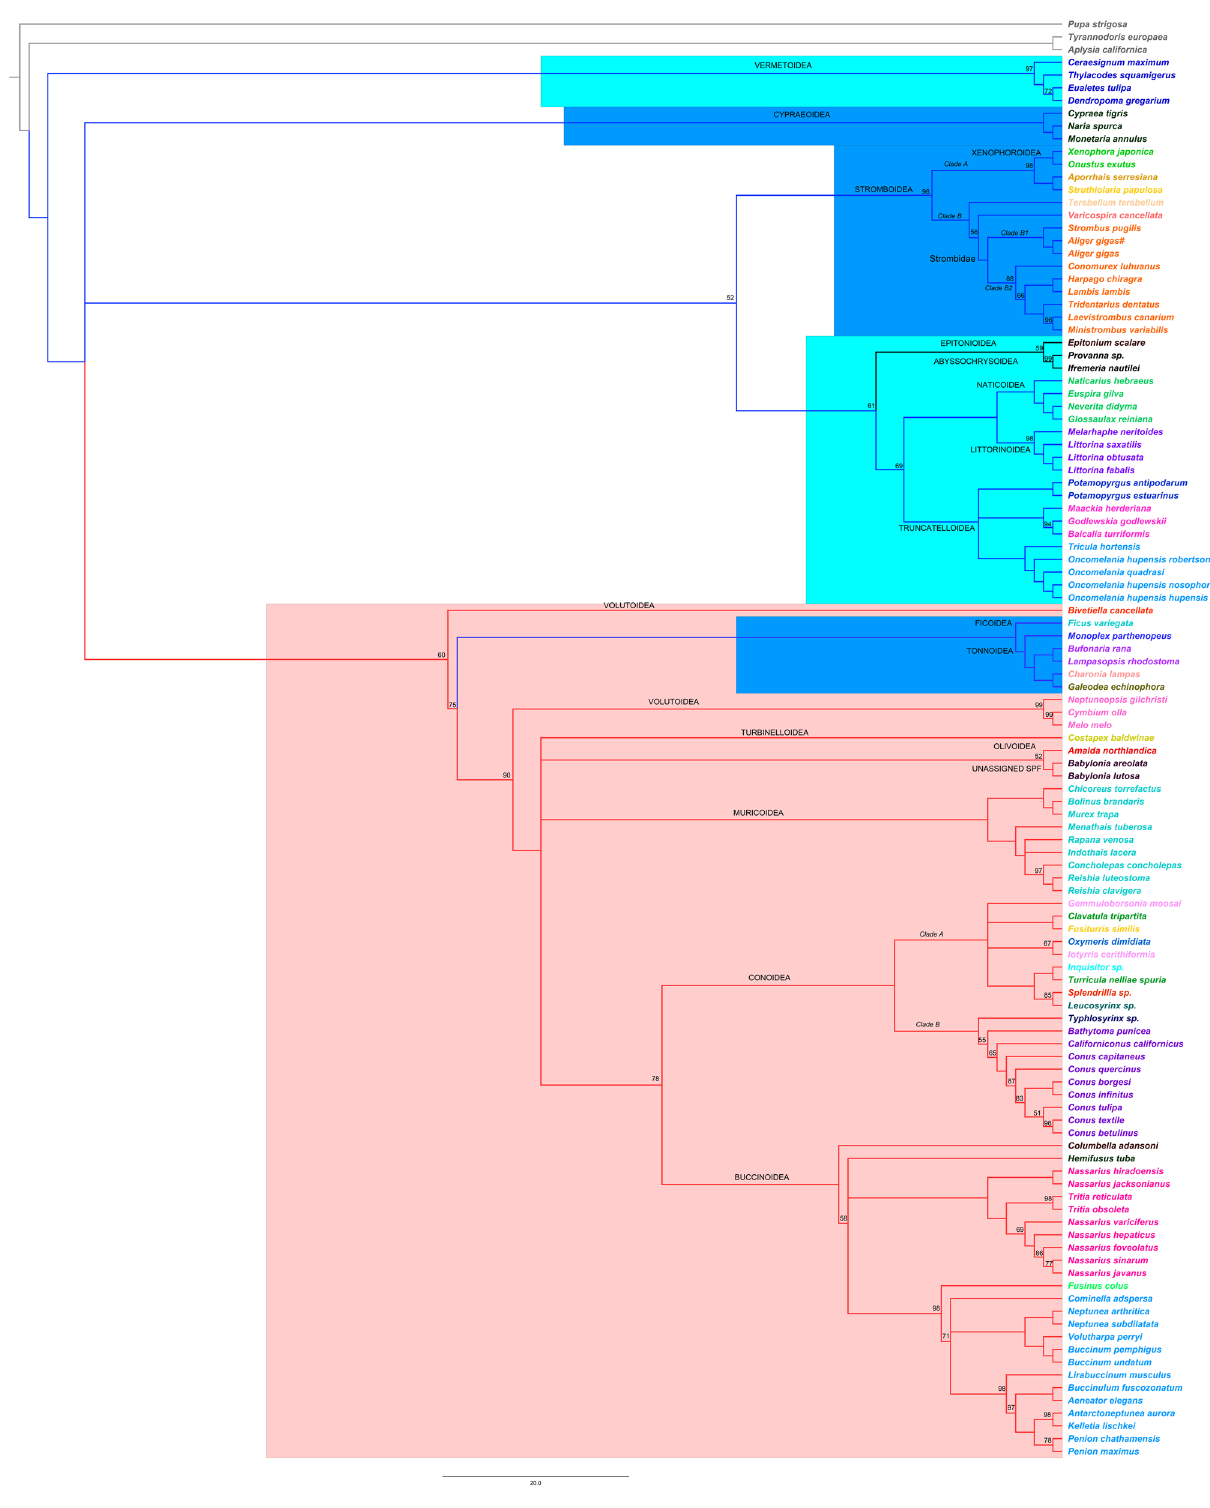
Figure 3. Maximum likelihood phylogenetic tree based on the concatenated nucleotide alignment of the 13 PCGs of 110 Hypsogastropoda mitogenomes. Numbers above branches indicate bootstrap values (branches without a number have a bootstrap of 100). Branch colors follow the classification of Bouchet & Rocroi (2005): Littorinimorpha (blue), Neogastropoda (red), outside both clades (black). Clades proposed by Bouchet et al. (2017) are highlighted: Latrogastropoda (red), Latrogastropoda “uncertain position” (dark blue), Non- Latrogastropoda (light blue). Names of SPFs labeled on branches, and species names are organized and colored by family. The # symbol signals specimen of A. gigas sequenced in this study. Three Heterobranchia species were used as outgroups ( Pupa strigosa , Aplysia californica , and Tyrannodoris europaea ). See Table S1 for